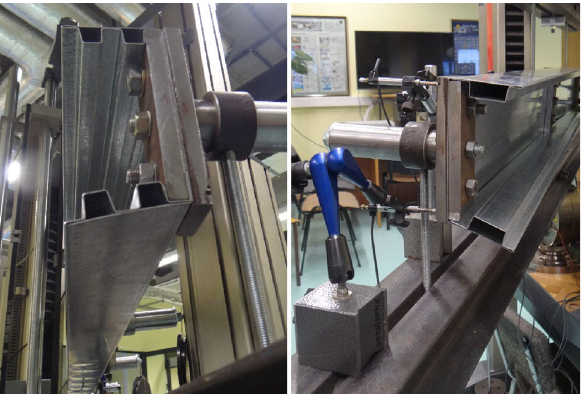
Figure 9. Deformation of cross section beam during experiment of four-point